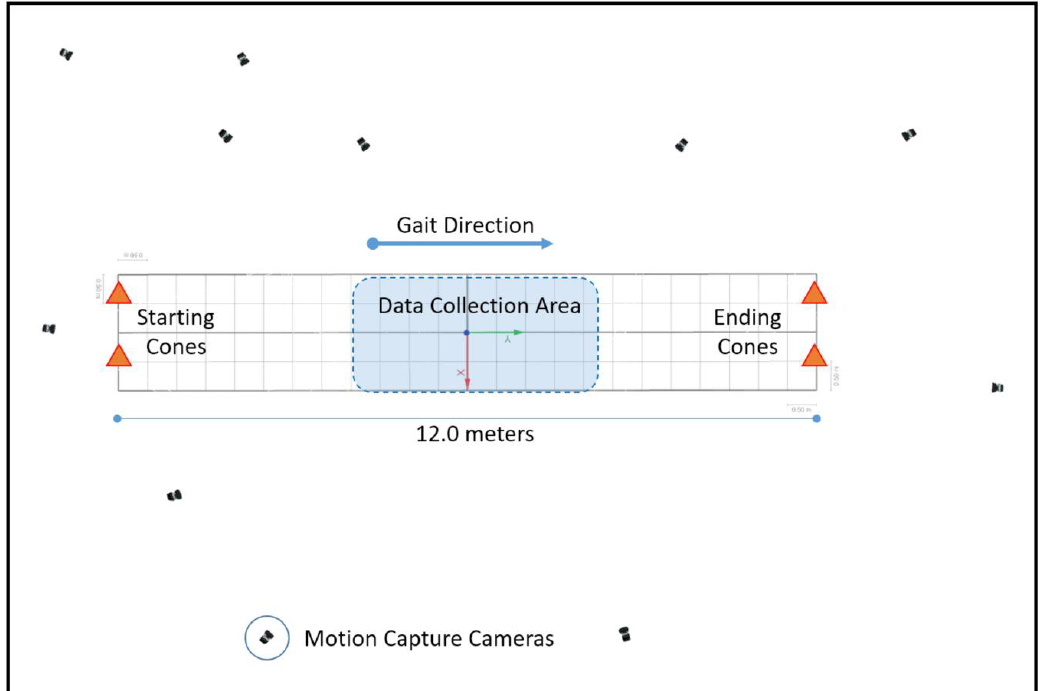
Sensors 2021 , 21 , x FOR PEER REVIEW Figure 1. Data collection area for the different walking speeds, camera set-up around the court, and movement direction. A modified conventional gait model was used to define body segments with 6 de- grees of freedom. Forty-three reflective markers were attached to the body with double- sided adhesive over the following anatomical landmarks: left/right anterior lateral head (located approximately over temple), left/right posterior lateral head (located on the back of the head, roughly in a horizontal plane of the front head markers), left/right acromion, deepest point of incisura jugularis, xiphoid process (sternum), spinous process of the sev- enth cervical vertebrae, left/right lateral and medial epicondyles of the humerus, left/right radius and ulna styloid processes, left/right dorsum of the 2nd and the 5th metacarpal head, left/right anterior and posterior superior iliac spines, left/right most lateral promi- nence of the greater trochanter, left/right lateral and medial femur epicondyles, left/right lateral and medial prominence of the malleolus, left/right aspect of the Achilles tendon insertion on the calcaneus, and left/right dorsal margin of the 1st, 2nd, and 5th metatarsal heads. In addition, reflective marker clusters comprising four markers on a rigid base were attached over the lateral mid-thigh and lateral mid-calf of each leg with the help of Superwarp (Fabrifoam, Exton, PA, USA) elastic bandages (Figure 2).